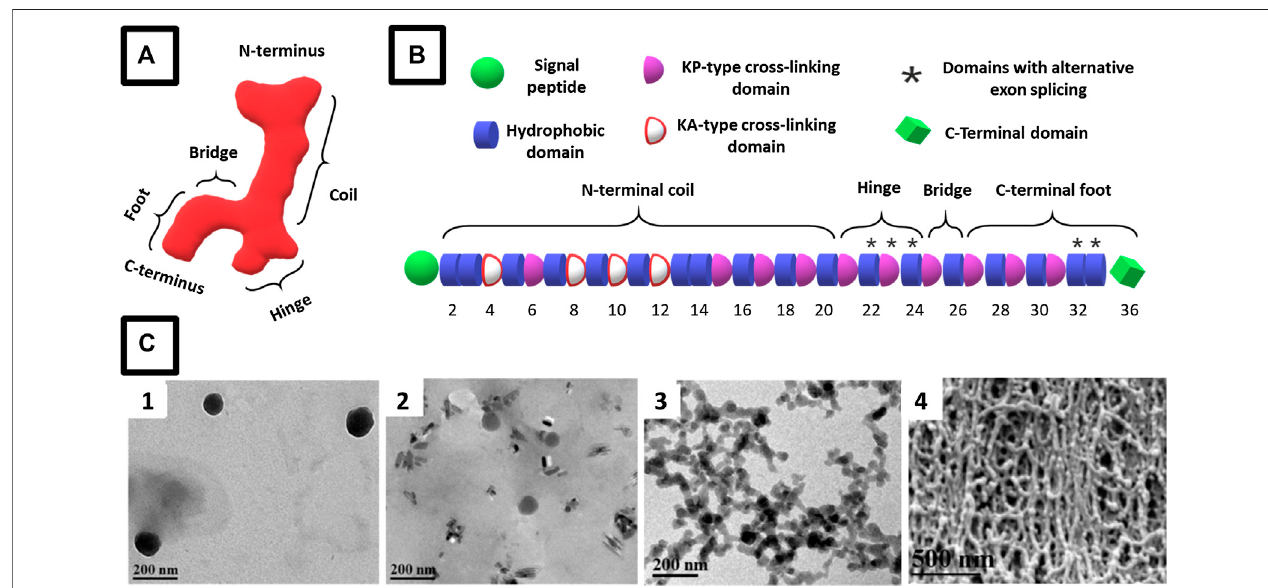
FIGURE 2 | Schematic representation of (A) the asymmetric structure of the tropoelastin monomer in solution with de fi ned modules that include segments specialized in elasticity (coil), cell binding (C terminus), and mechanical coupling (bridge) [adapted fromMithieux et al. (2013)] and (B) representative amino acid domains arrangement in a tropoelastin monomer (adapted from (Muiznieks and Keeley (2013)). (C) Representative micrographs of the evolution of amphiphilic ELR assemblies showingtypicalcoacervationgrowthfrom(C1)nanosizedmicellesat1 mg/mlthat(C-2)growinsizeat10 mg/mland(C-3)aggregateintoclustersat50 mg/mlthat eventually form self-assembled fi brils at 100 mg/ml. [C 1-4 micrographs reproduced with permission from (Misbah et al., 2015), copyright 2015, Elsevier B.V.]